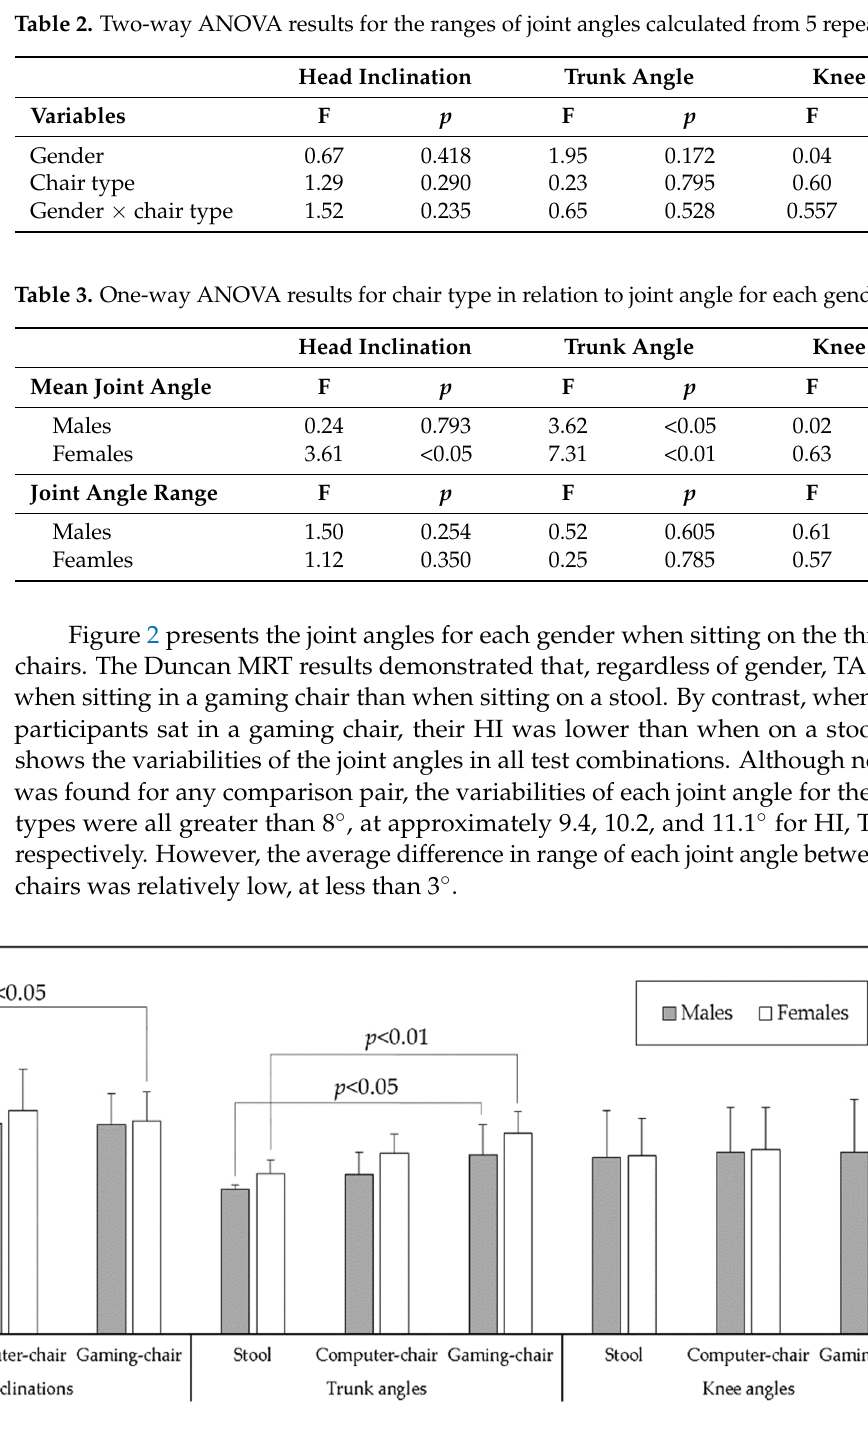
Table 1. Two-way ANOVA results for mean joint angles calculated from 5 repeated trials.